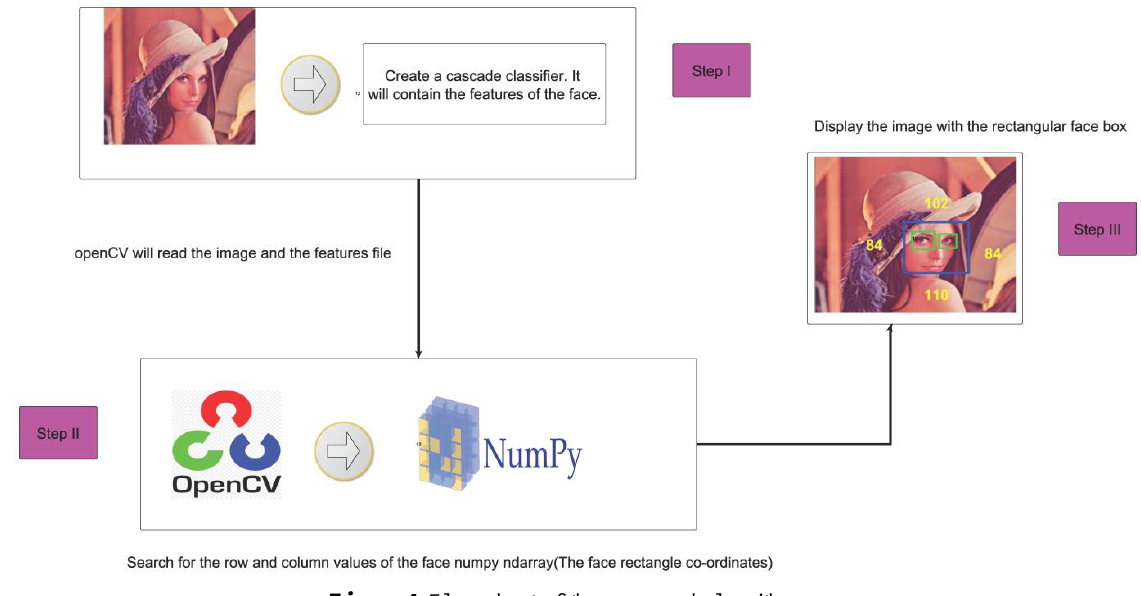
Figure 4. Flow chart of the proposed algorithm.